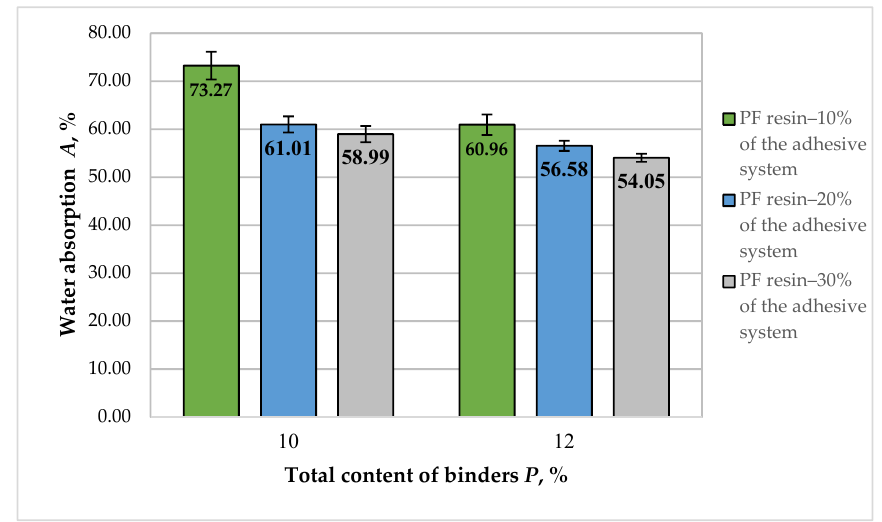
Figure 11. Water absorption (24 h) of fiberboard panels bonded with HL and PF resin. Lignocellulosic materials absorb water by creating hydrogen bonds between water and hydroxyl groups of lignin, cellulose, and hemicellulose present in the cell wall [86,87]. The addition of lignin in the adhesive system reduces the WA of fiberboards due to the presence of aromatic rings and non-polar hydrocarbon chains in the lignin structure [88]. WA values of the fiberboard panels produced in this work varied from 73.27% to 54.05%. The variation of the total binder content and adhesive system composition resulted in reduced WA of the panels by 1.36 times. The reduced WA values with the incorporation of lignin in the adhesive formulation might be attributed to bulking the cell wall with lignin, which makes it hydrophobic [19,29].